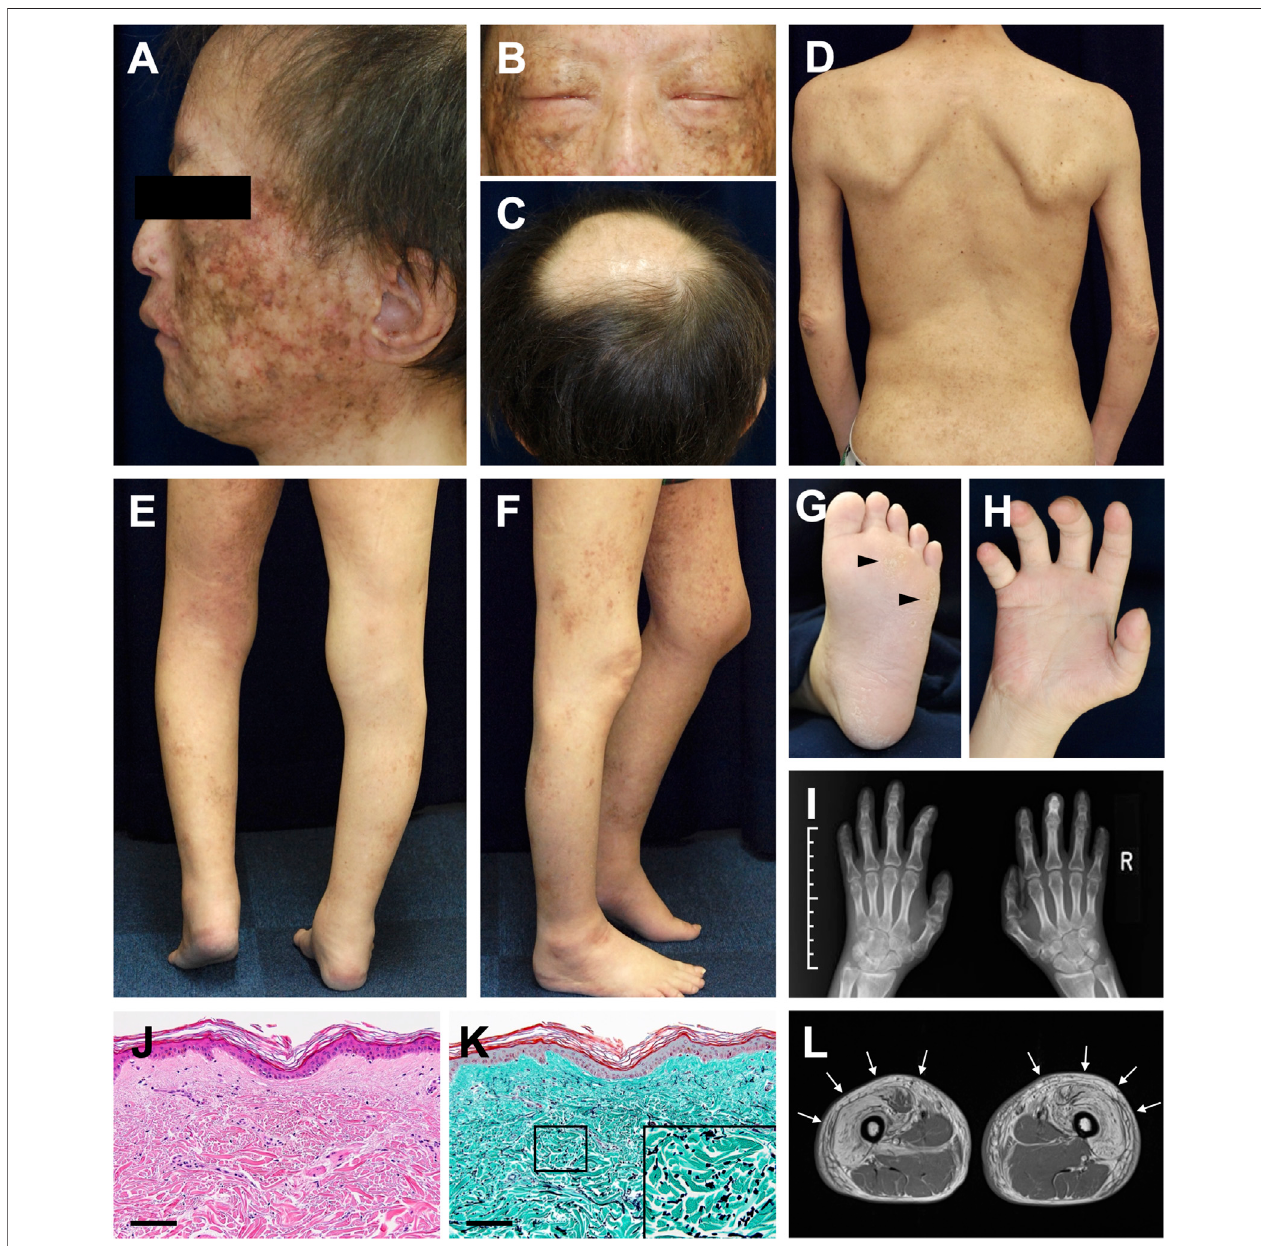
FIGURE 1 | Clinical and histopathological manifestations (A) Poikiloderma with mottled pigmentation and telangiectasia on the face (B) Sparse eyebrows and eyelashes and lagophthalmos (C) Hairless on top of the head (D) Dry skin, mild eczema, and smallpigmented macules with skin sclerosis (E,F) Mild lymphedema of the lower limbs (E) and contracture of the left Achilles tendon (F) (G) Mild hyperkeratosis with calluses (arrowheads) on the sole (H) Impaired extension of the fi ngers (I) Mild hypoplasia of the hands evaluated using X-ray photography (J) Pathological features of the non-sun-exposed area of the anterior chest. Hematoxylin and eosin (H&E)stain(scalebar,100 μ m) (K) Elastica – Massonstaining.Theinsetshowsahigh-magni fi cationimageoftheareaindicatedinthebox(scalebar,100 μ m). (L) Diffuse bright appearance (white arrows) of the bilateral quadriceps muscles detected with muscle MRI (T1-weighted